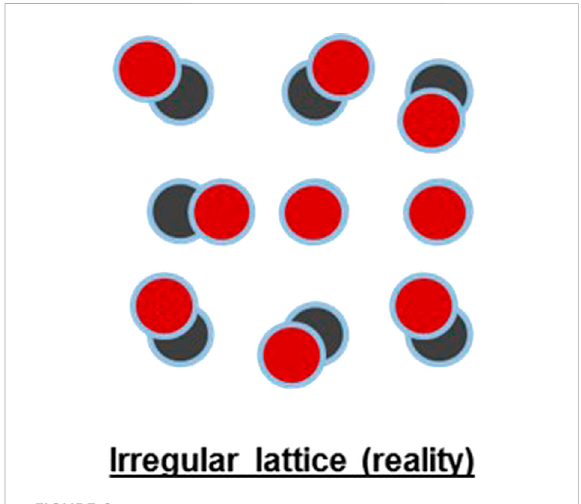
FIGURE 8 Example of rod positioning via simulations with prométhée.